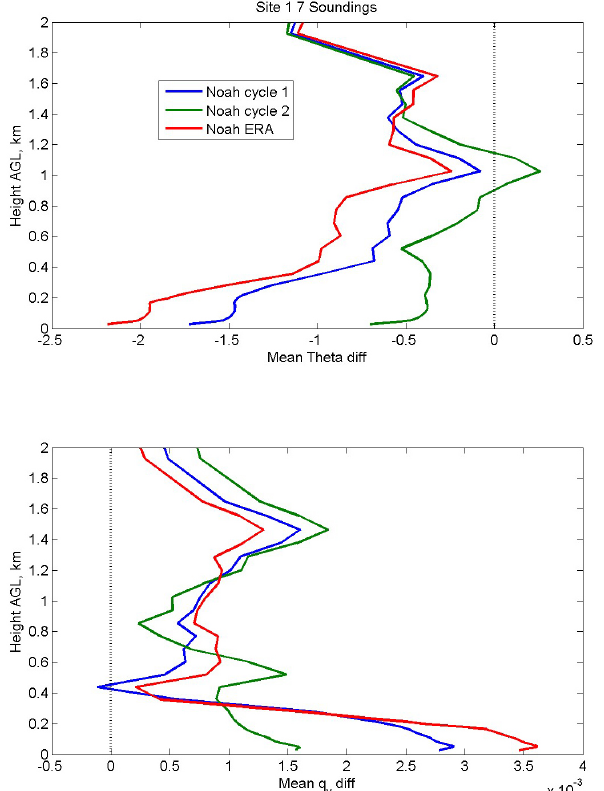
Figure 1. Mean difference (model – measurement) of potential temperature (top) and specific humidity (bottom) for seven ∼ 17:00UTC soundings (24, 25, 26, 27, 30 June, 1, 2 July) at site 1. Model results are from the nearest grid point.